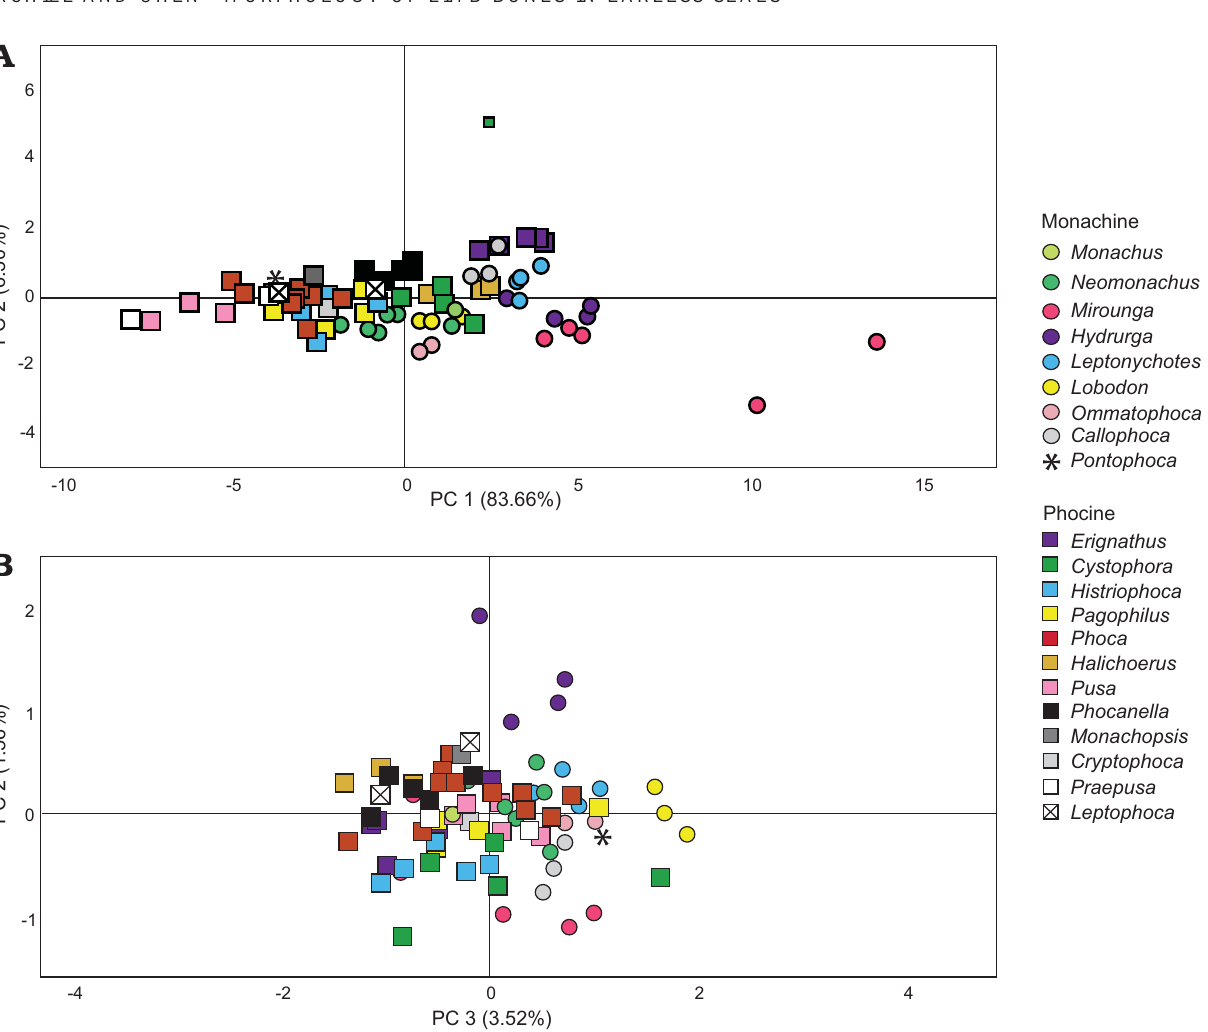
Fig. 4. Results of PCA for the femur measurement data, including extant and fossil earless seal taxa. A . PC1 vs. PC2. B . PC3 vs.